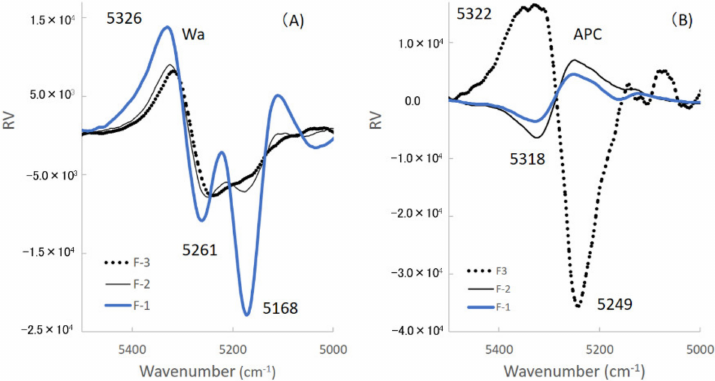
Figure 9. Regression vectors of the calibration models to predict the amount of water added and the agitation power consumption respectively of all formulations. ( A ) The amount of water added (Wa); ( B ) the agitation power consumption